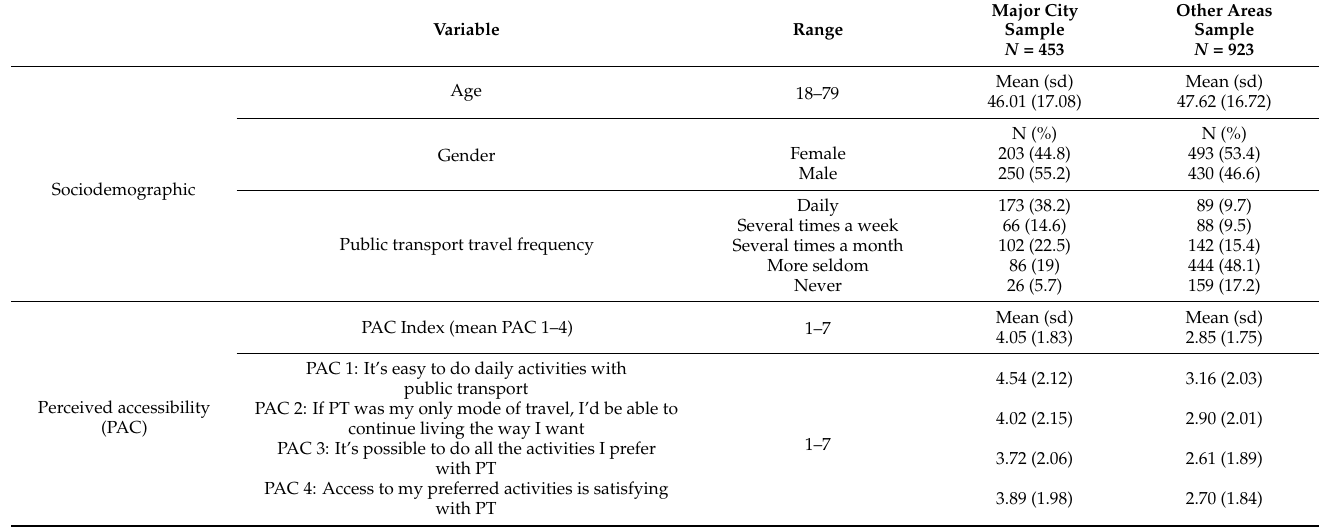
Table 1. Sample descriptives and number of participants for all variables